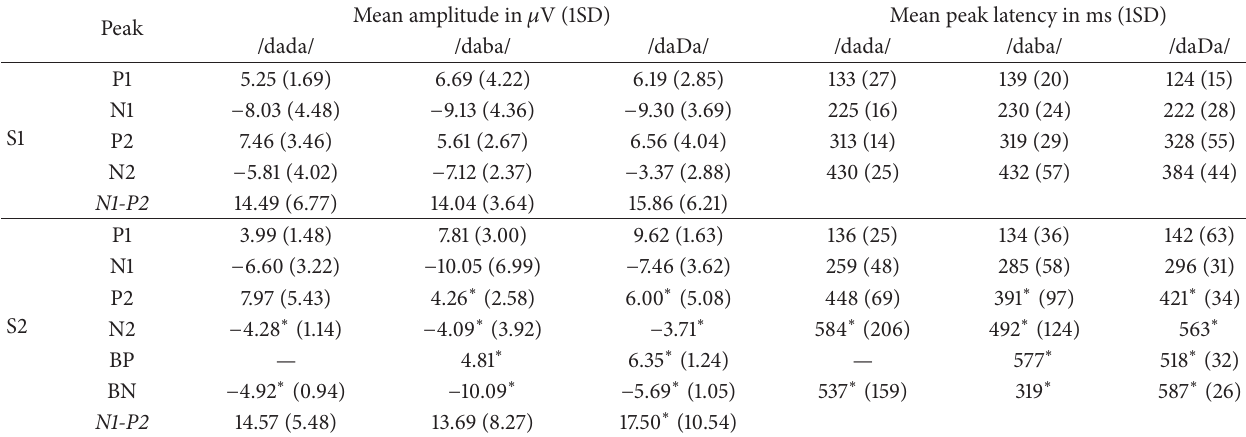
Table 4: Infants: mean (1SD) baseline-to-peak amplitude and peak latency measurements for individual components of the waveform elicited to the S1 and S2 portion of the /dada/, /daba/, and /daDa/ stimulus conditions are shown. The latencies were measured from the onset of the S1 stimulus and from the onset of the change in the stimulus at S2. Mean (1SD) N1-P2 amplitudes are also indicated. Mean values that represent measurements from fewer than five responses are denoted with an asterisk ( ∗ ). The dashed line indicates that no responses were detected. The terms “BP” and “BN” denoted “broad positive” and “broad negative” peaks, respectively.